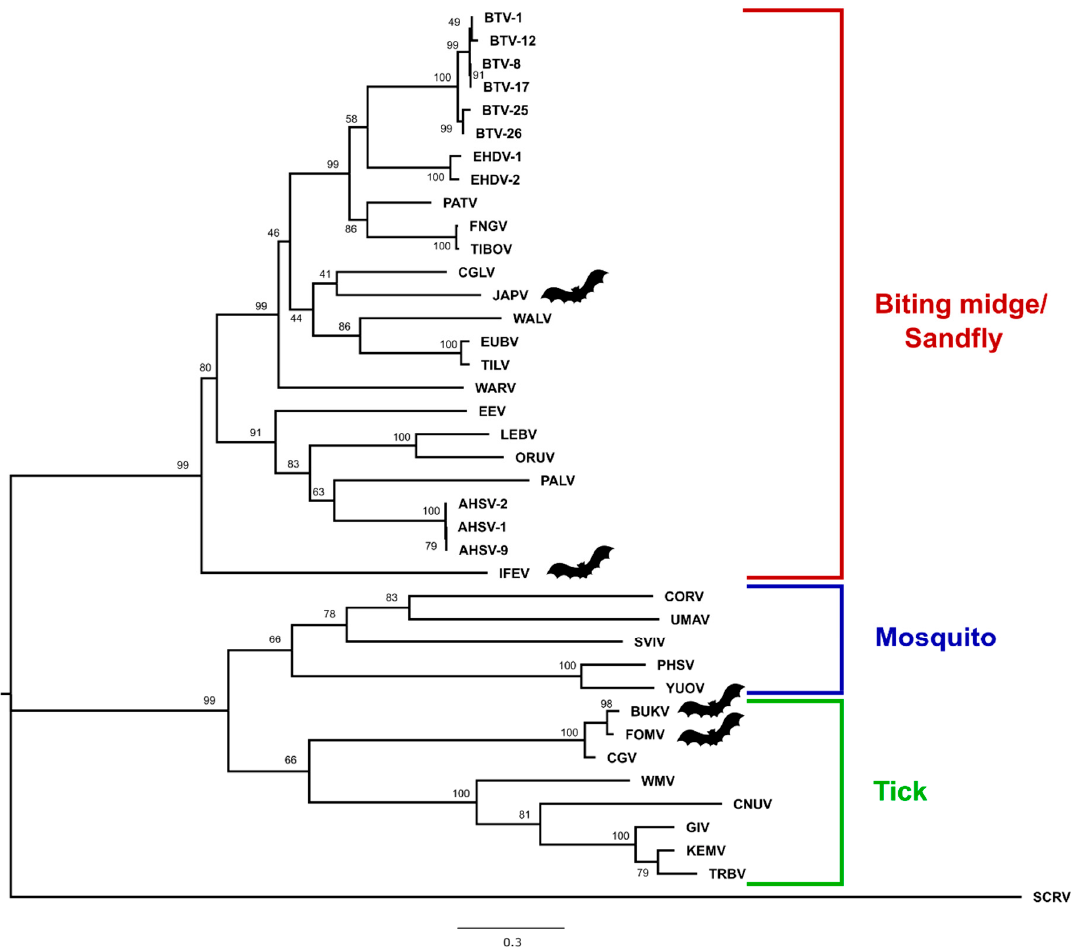
Figure 4. Maximum-likelihood phylogenetic tree of the outer core protein (T13) of selected orbiviruses (amino acid) constructed in MEGA7 using 1000 bootstrap replicates. The tree is drawn to scale, with branch lengths measured in number of substitutions per site. The tree was rooted with St. Croix River virus (SCRV). Bat symbols identify the viruses sequenced in this study. Full virus names are provided in the Materials and Methods section and accession numbers are provided in Table S1.